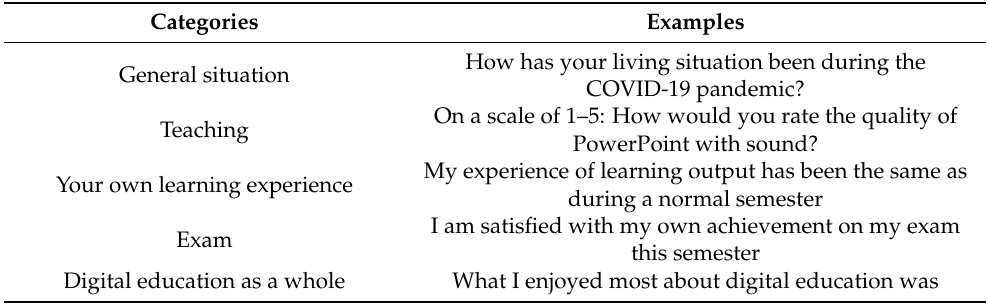
Table 1. The questionnaire was divided in five main categories. The table illustrates the different categories and includes an example of questions within each